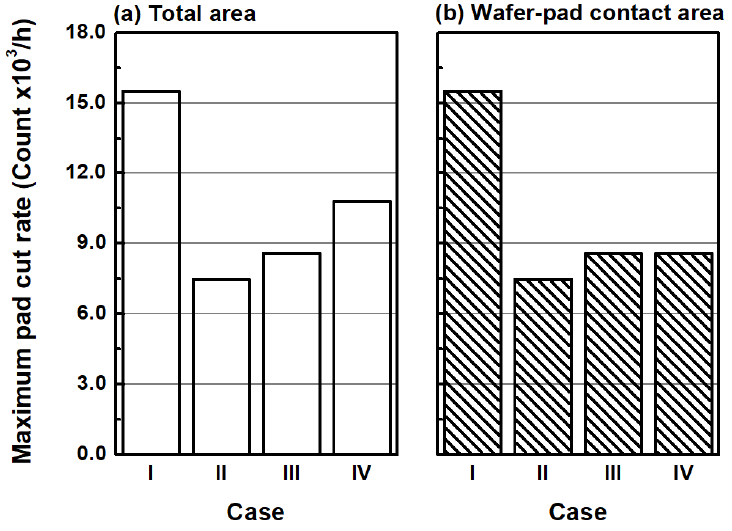
Figure 8. Average pad cut rate of conditioning cases: ( a ) total area and ( b ) wafer–pad contact area.